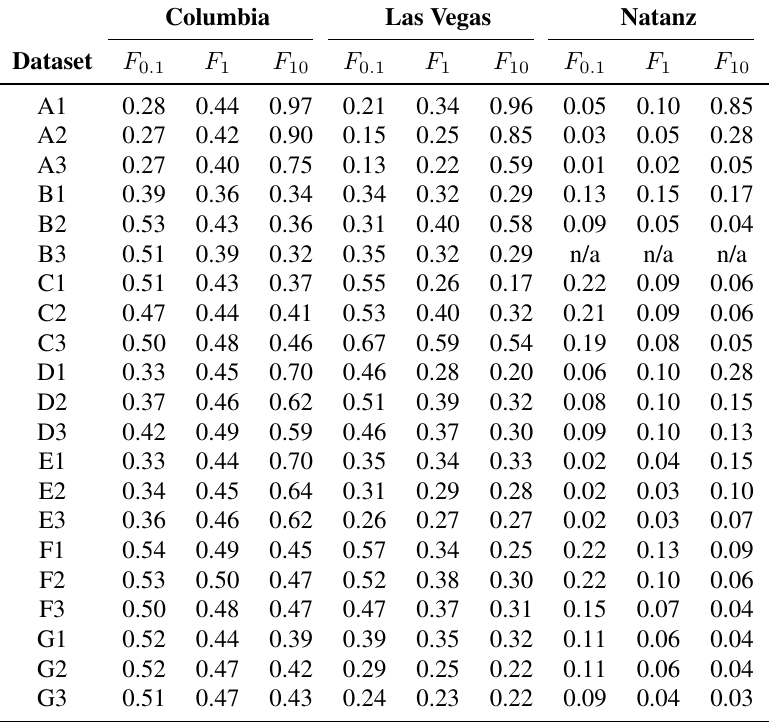
Table 13. Analysis of support vector machine change prediction results using a generalized